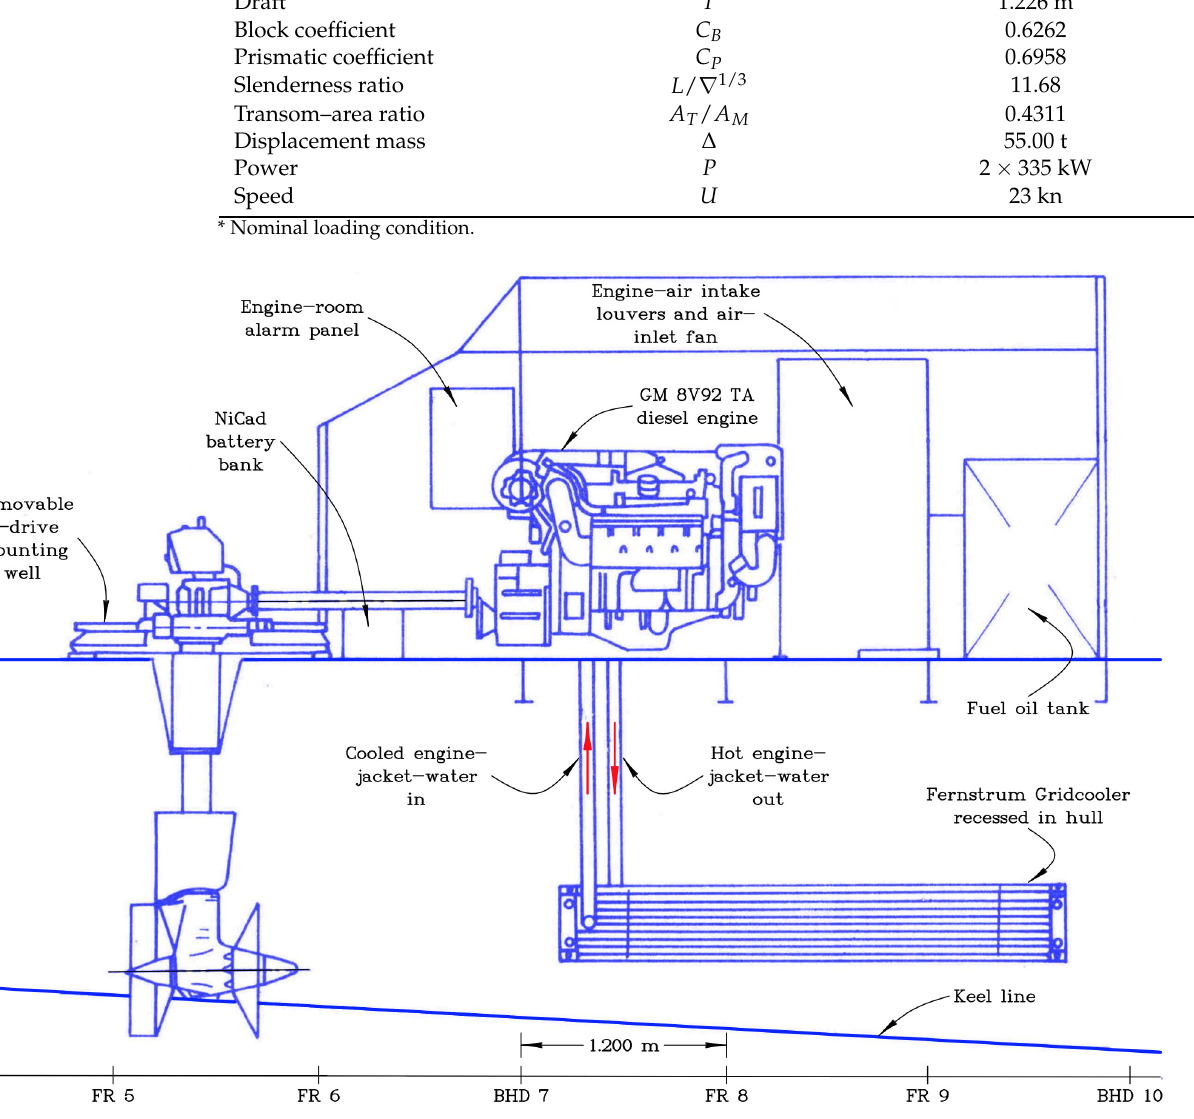
Figure 3. Profile of machinery